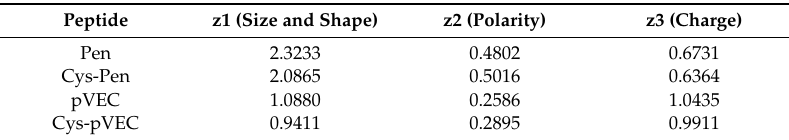
Table 2. Extracted z-scores for the studied peptides.